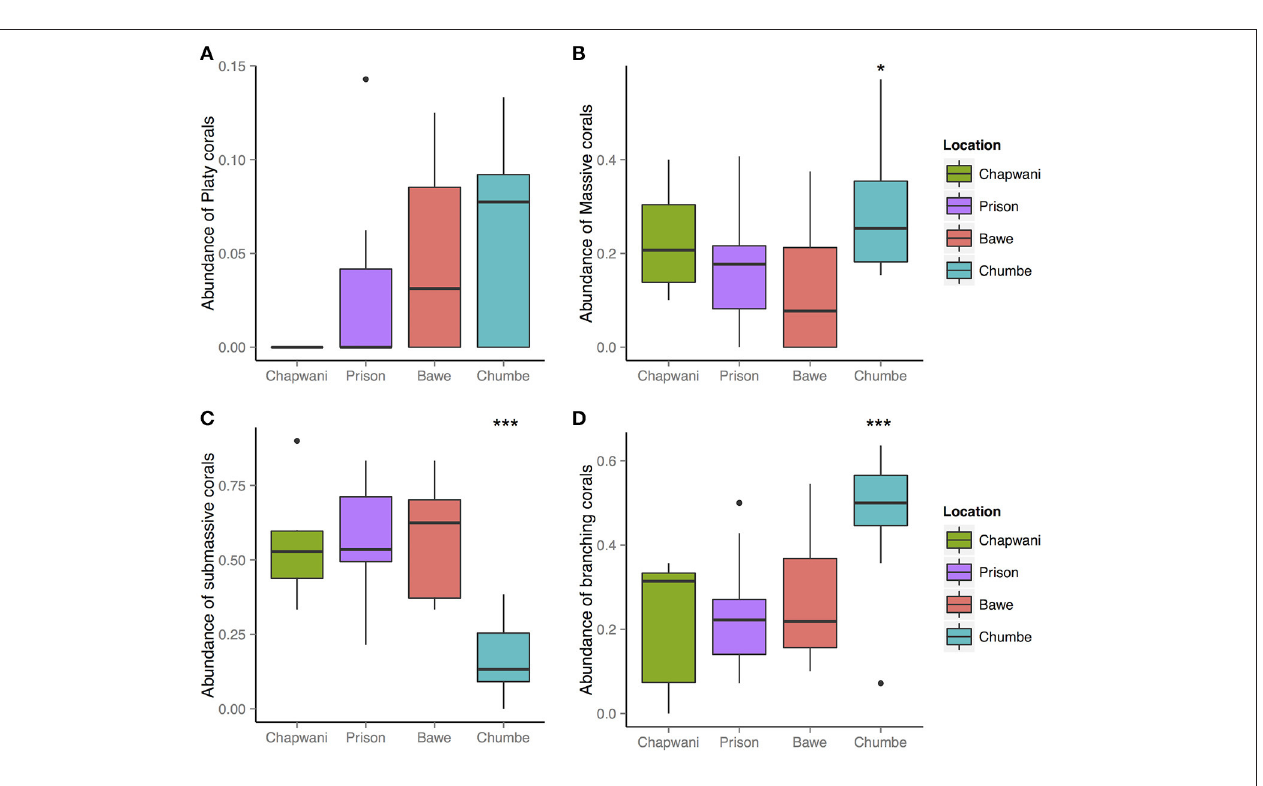
and almost no carbonate production from calcifying algae. The reef with the highest CCA percentage cover was Chumbe Reef (approx. 2%). Negligible occurrence was recorded on the other reefs ( <